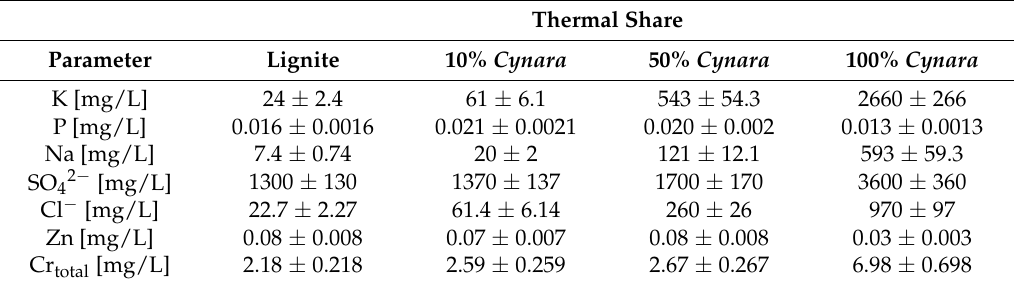
Table 6. Influence of an increasing Cynara thermal share on mobility of some species in the fly ashes. Thermal